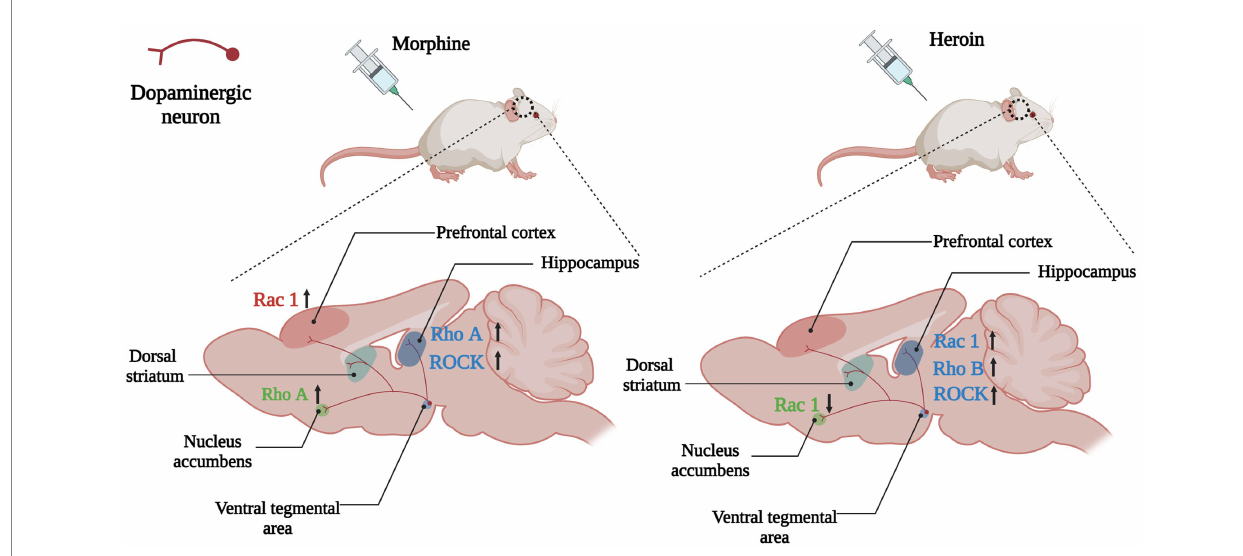
FIGURE 4 Changes of Rho GTPases expression in brain induced by opioids. In the mesolimbic dopamine system, the dopaminergic neurons in the ventral tegmental area (VTA) project to the brain regions involved in emotional, motivational, and executive functions such as the nucleus accumbens, hippocampus, dorsal striatum and prefrontal cortex. Opioids such as morphine and heroin abuse lead to changes in expressions of Rho GTPases in the mesencephalic limbic dopamine system, which in turn cause cytoskeleton remodeling and synaptic morphological and functional changes of dopamine neurons, leading to addiction and relapse. Arrows are used to represent changes in Rho GTPases and their downstream molecules in different brain regions caused by addictive substances, with upward arrows indicating increased expression and downward arrows indicating decreased expression. The color of the Rho GTPases and their downstream molecules coincides with the color of the brain regions in which they are differentially expressed. For example, the pink Rac1 in the left panel indicates changes in Rac1 expression in the prefrontal cortex (also the pink brain region) caused by morphine, and the upward arrow in the back indicates increased Rac1 expression in the prefrontal cortex caused by